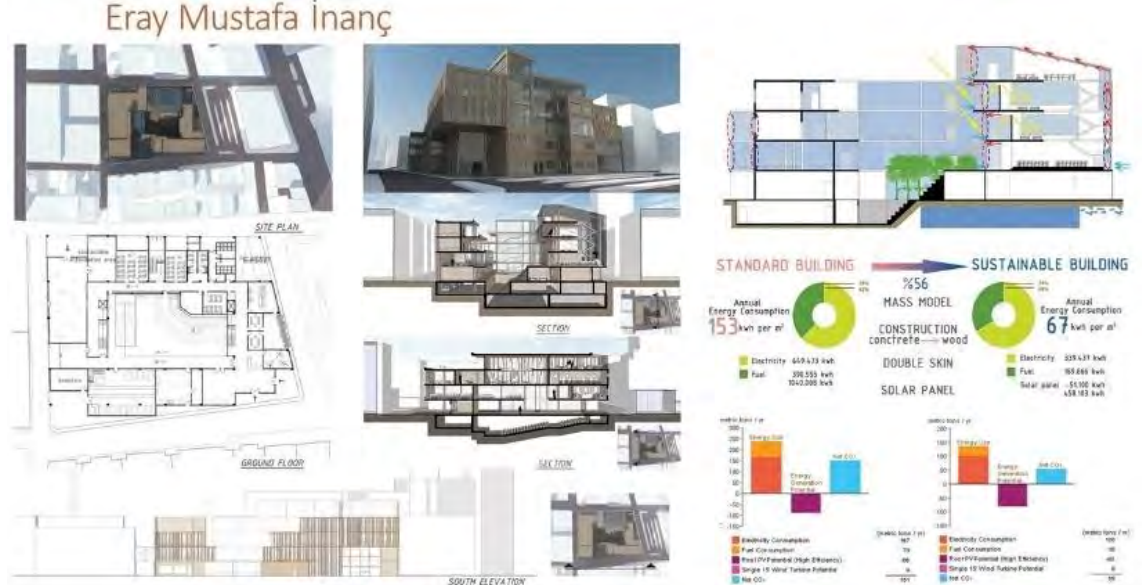
Figure 1. The designed Architecture department project incorporate the use of; natural light, natural ventilation, sustainable materials (totally constructed out of wood), double skin fac¸ade,shading elements, green elements, collecting rain water, reuse of grey water, and solar panels. The proposed design had %56 reduction in annual energy consumption.